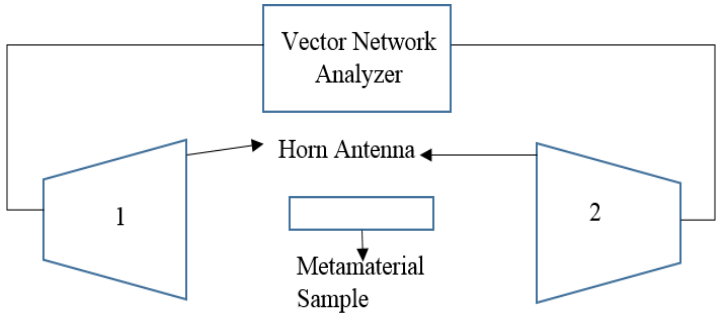
Figure 14. Experimental set-up for the measurement of S